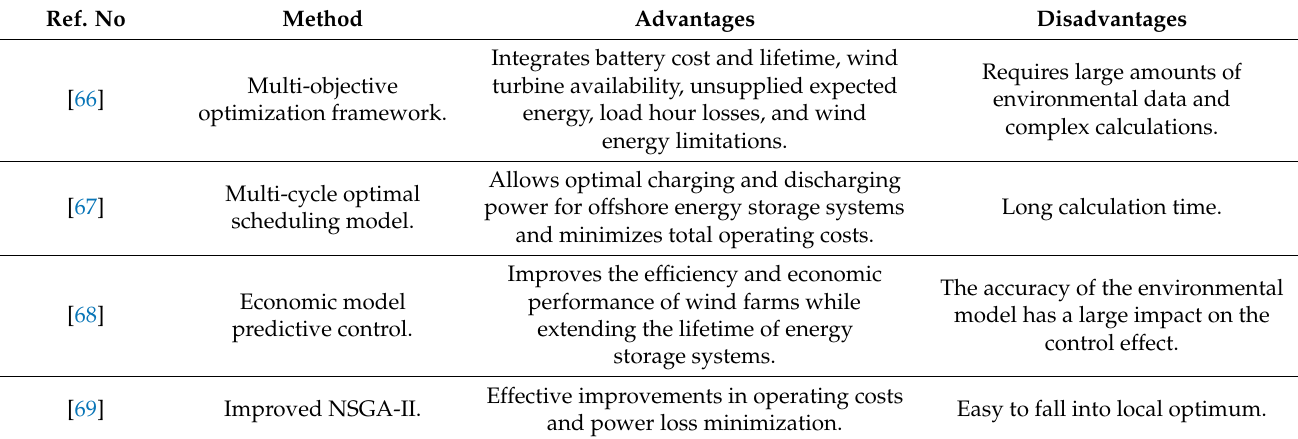
Table 3. Offshore wind storage integrated system scheduling